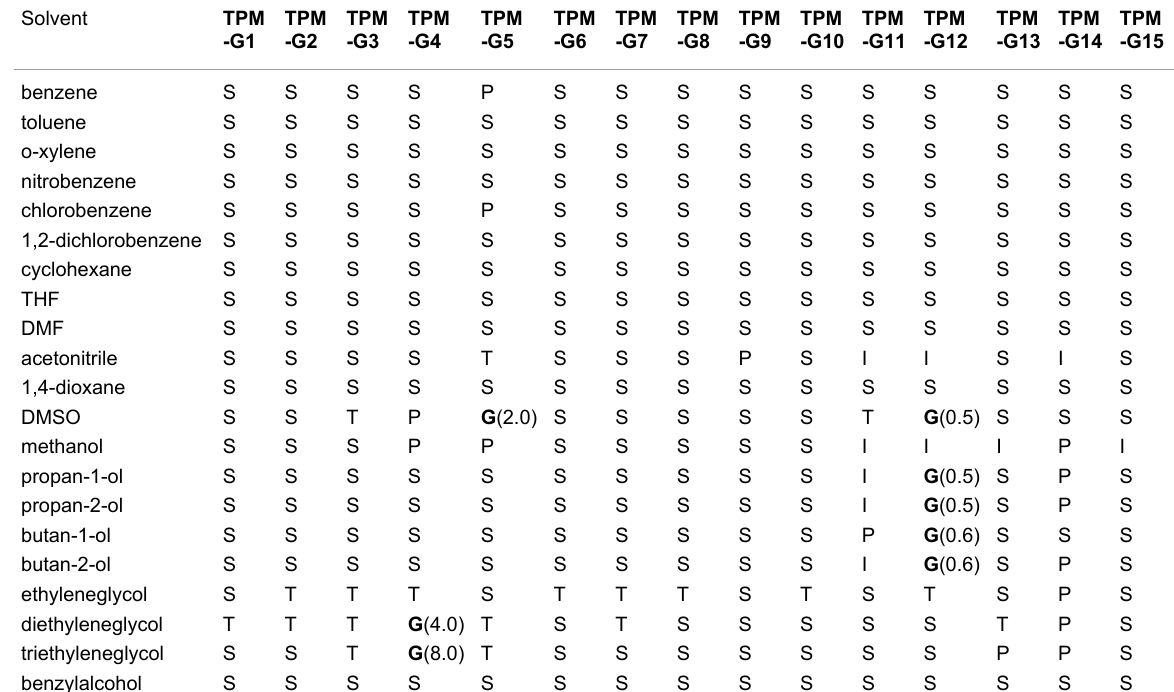
a Values given inside the brackets denote the minimum gel concentration (MGC, % w/v ) to form organogels at room temperature. G: gel; S: solution; P: precipitate; I: insoluble; T: turbid. b THF, DMSO, and DMF indicate tetrahydrofuran, dimethyl sulfoxide and N , N -dimethylformamide, respectively.